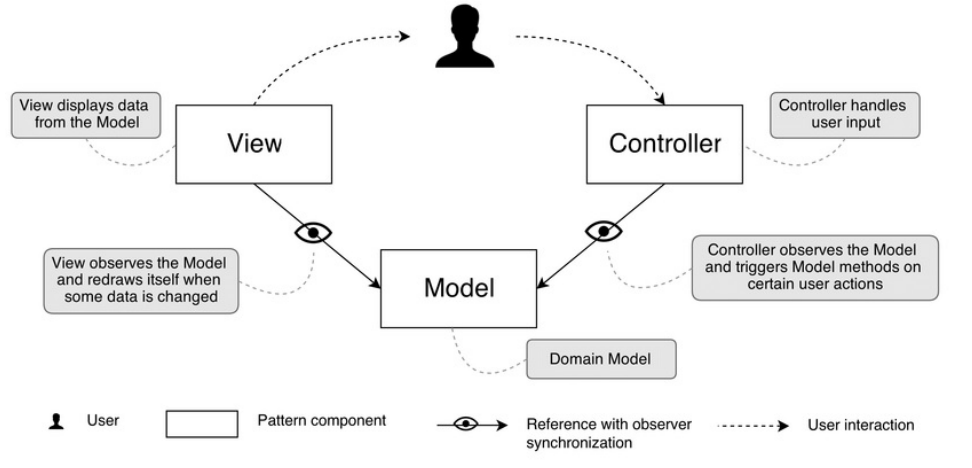
Fig. 1 MVC mode. MVC,